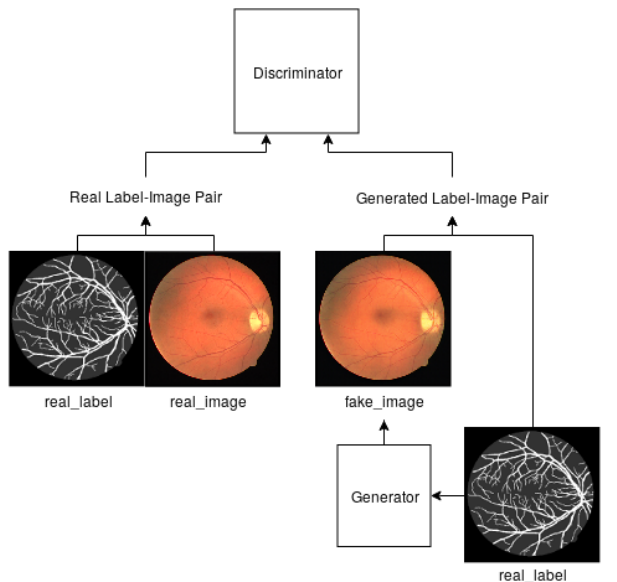
Figure 4. Scheme of the Pix2Pix training framework employed to translate label-maps into retinal